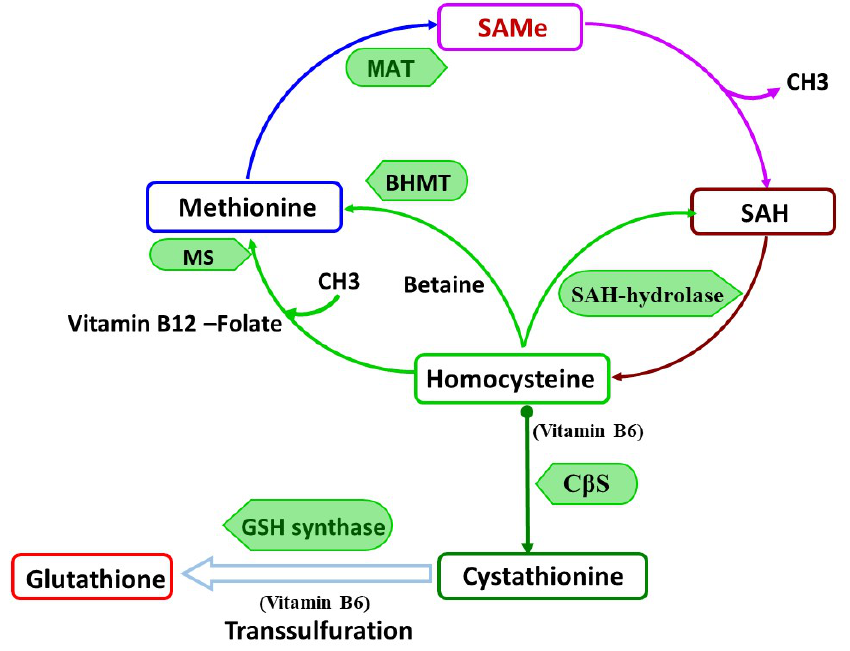
Figure 1. S -adenosylmethionine (SAMe) metabolism.